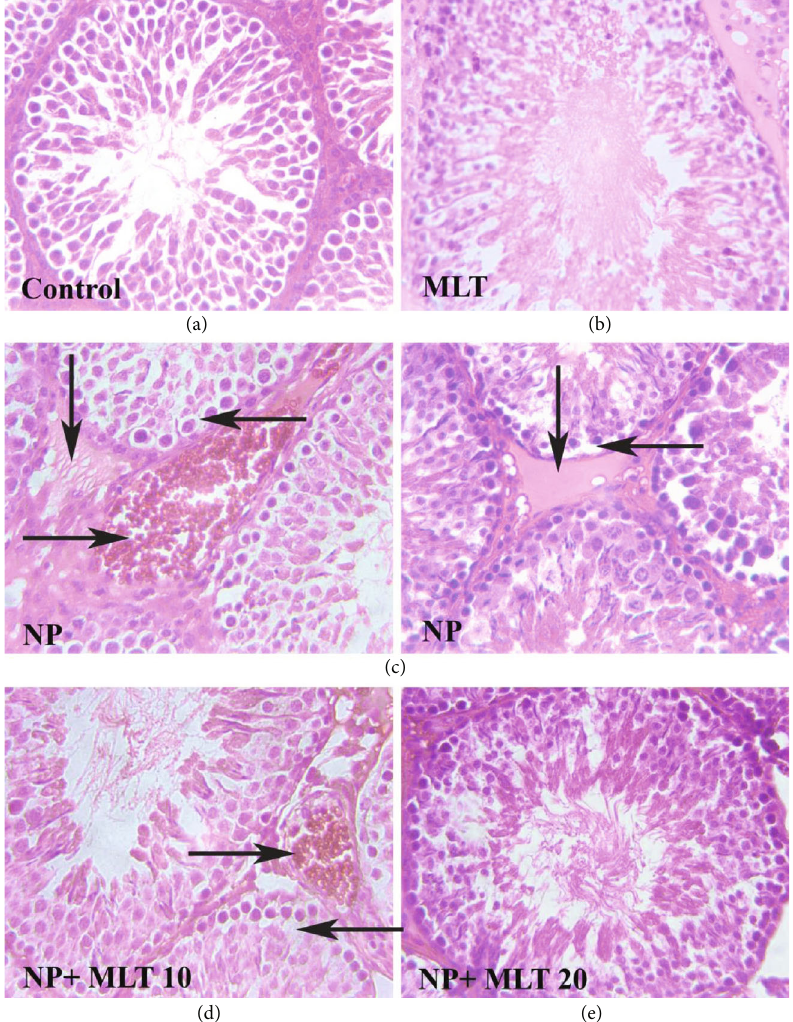
Figure 6: MLT improved histopathological changes induced by NP in the adult testis. Representative photomicrographs of the testis of fi rst- generation adult male rats (H&E stain, × 40) ( n = 4 ). Control group (a), MLT20 group (b), NP25 group (c), NP+MLT10 group (d), and NP +MLT20 group (e). (a) Shows normal tissue conditions in the control group; (b) normal tissue conditions and increased spermatozoa population in the MLT20 group; (c) hyperemia (right arrow), edema (down arrow), and vacuolar degeneration (arrow left) in the NP25 group; (d) hyperemia (arrow to the right) and vacuole degeneration (arrow to the left) in the NP+MLT10 group; and (e) normal tissue conditions in the NP+MLT20 group. NP: nonylphenol; MLT: melatonin. Table 3: Histopathological examination of the testicular tissue. Decrease Groups Edema Hyperemia